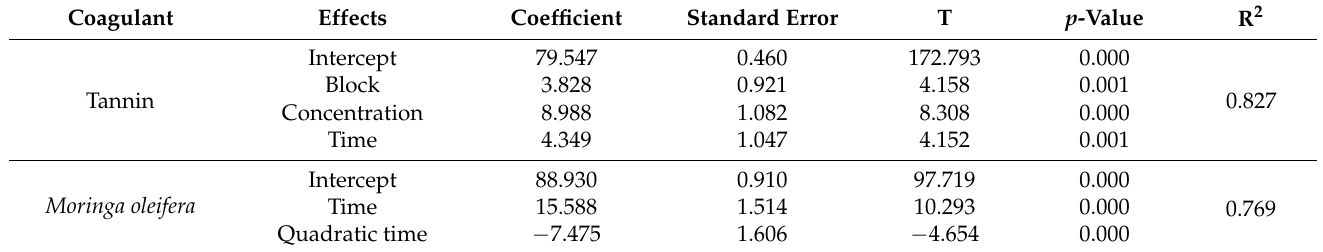
Table 5. Significant effects for the turbidity parameter for coagulation, flocculation, and sedimentation (C/F/S) process using tannin and Moringa oleifera in the presence and absence of magnetite.